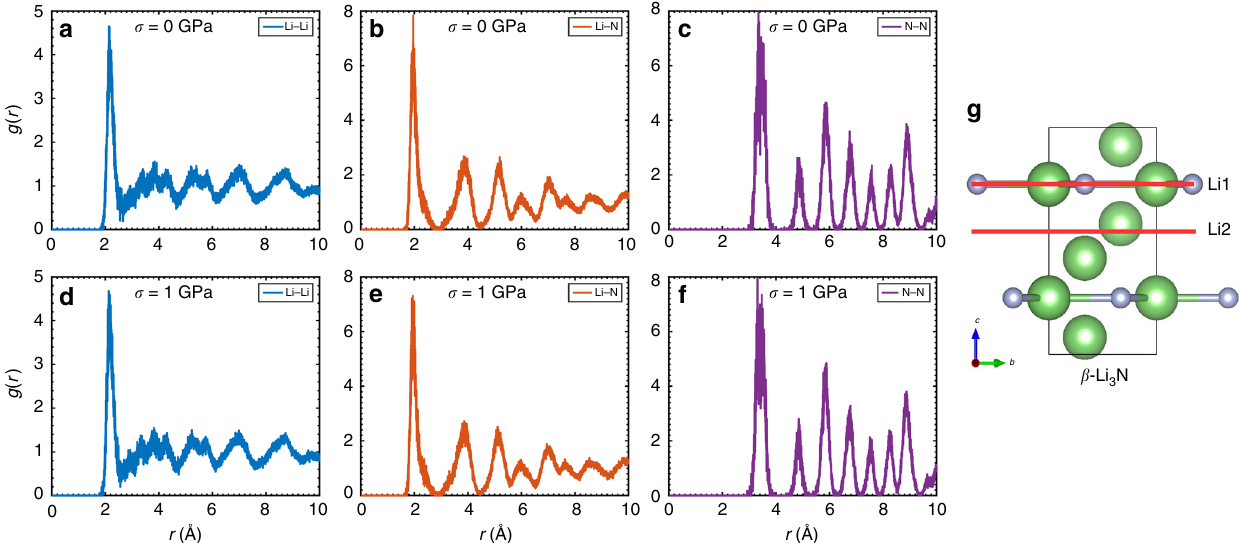
Fig. 3 Structural properties of β -Li 3 N at equilibrium and under pressure. Radial pair distribution function obtained for the a , d Li – Li, b , e Li – N, and c , f N – N pairs at T = 300 K. g Two planes perpendicular to the hexagonal c -axis and containing different types of Li + ions, namely “ Li1 ” and “ Li2 ” , are indicated with red thick T = 300 K and σ = 1 GPa), and the corresponding pressure-